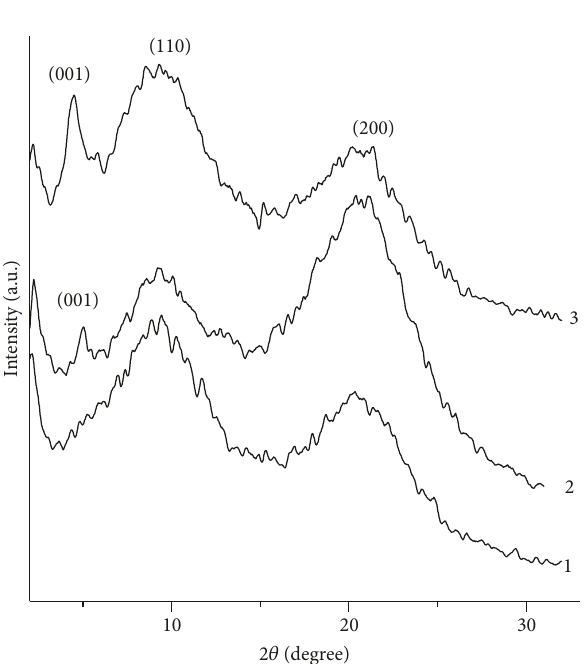
Figure 7: XRD patterns for HEC (1) , HEC/bentonite (1wt.% of filler) composite films (2) , and HEC/organobentonite (1wt.% of filler) composite films (3)